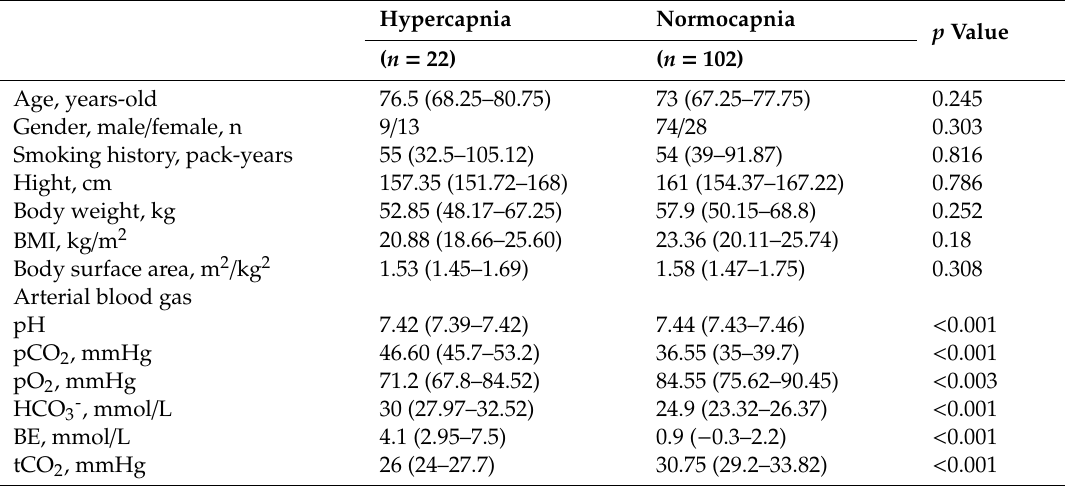
Table 1. Background characteristics of enrolled subjects with COPD.